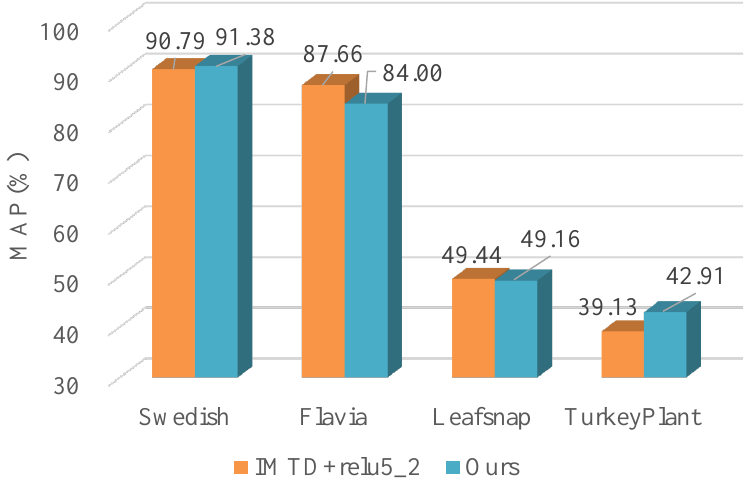
Figure 14. Retrieval MAP performance comparison between our method and the state-of-the-art method IMTD+relu5_2.